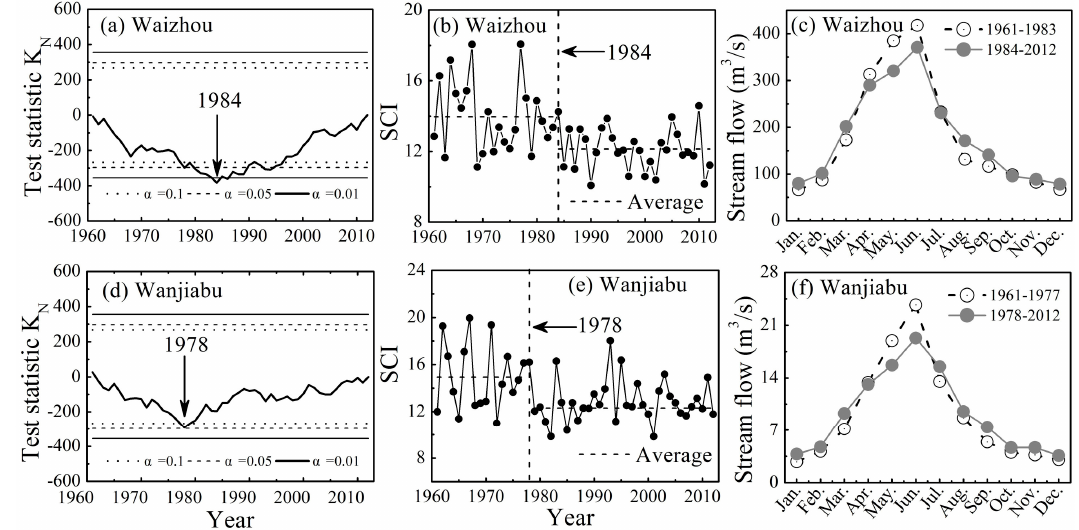
Figure 4. Pettitt test in SCI series at Waizhou station ( a ); change of average SCI before and after the change point at Waizhou station ( b ); intra ‐ annual distribution of stream flow before and after the change point at Waizhou station ( c ); Pettitt test in SCI series at Wanjiabu station ( d ); change of average SCI before and after the change point at Wanjiabu station ( e ); intra ‐ annual distribution of stream flow before and after the change point at Wanjiabu station ( f ).